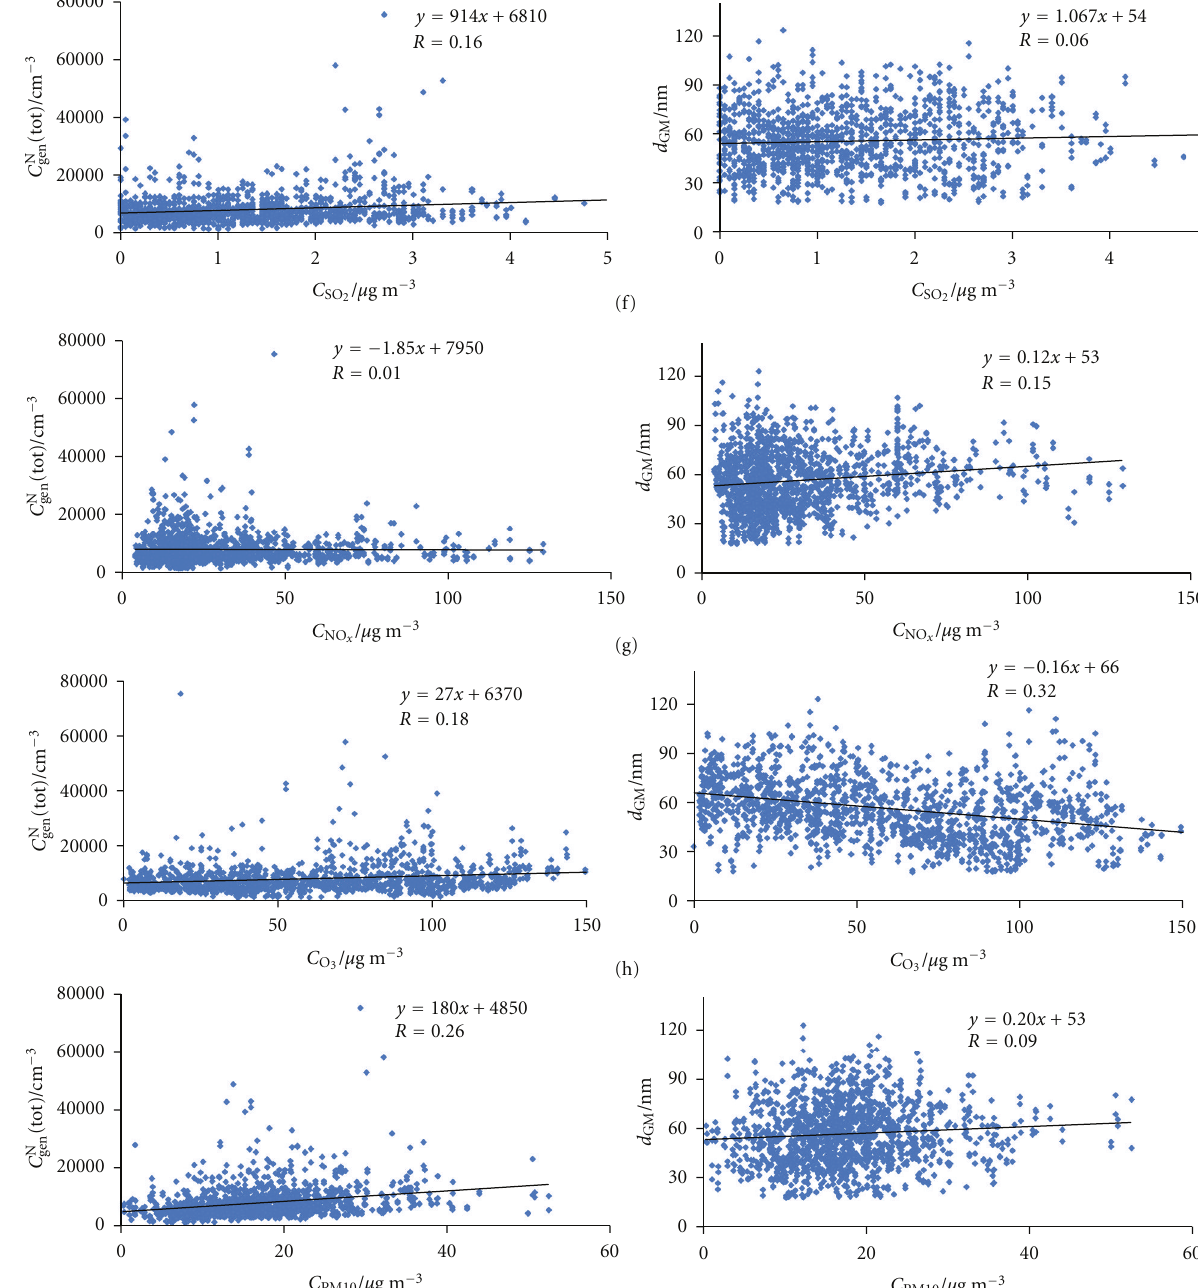
Figure 4: Correlations of the following relationships in outdoor air for the period May 3–June 6, 2010: (a) C N C